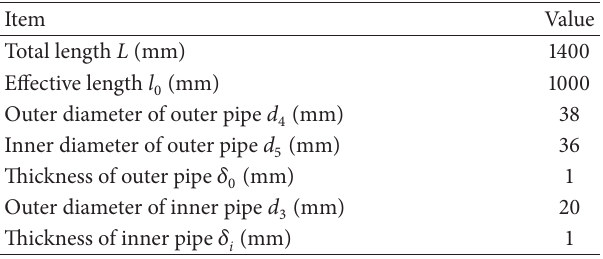
Table 4: Geometric parameters of double pipe of experiment II.